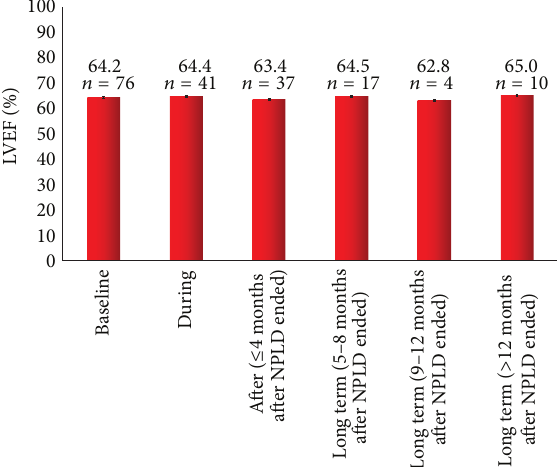
Figure 1: Kaplan-Meier survival plot for disease-free survival following surgery ( 𝑛 = 97 ). Figure2:Mean( ± standarderror)LVEFvaluesintheoverallpatient population.